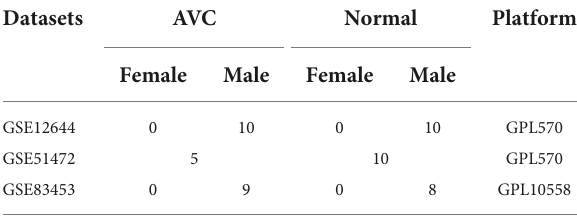
TABLE 1 The characteristic of three